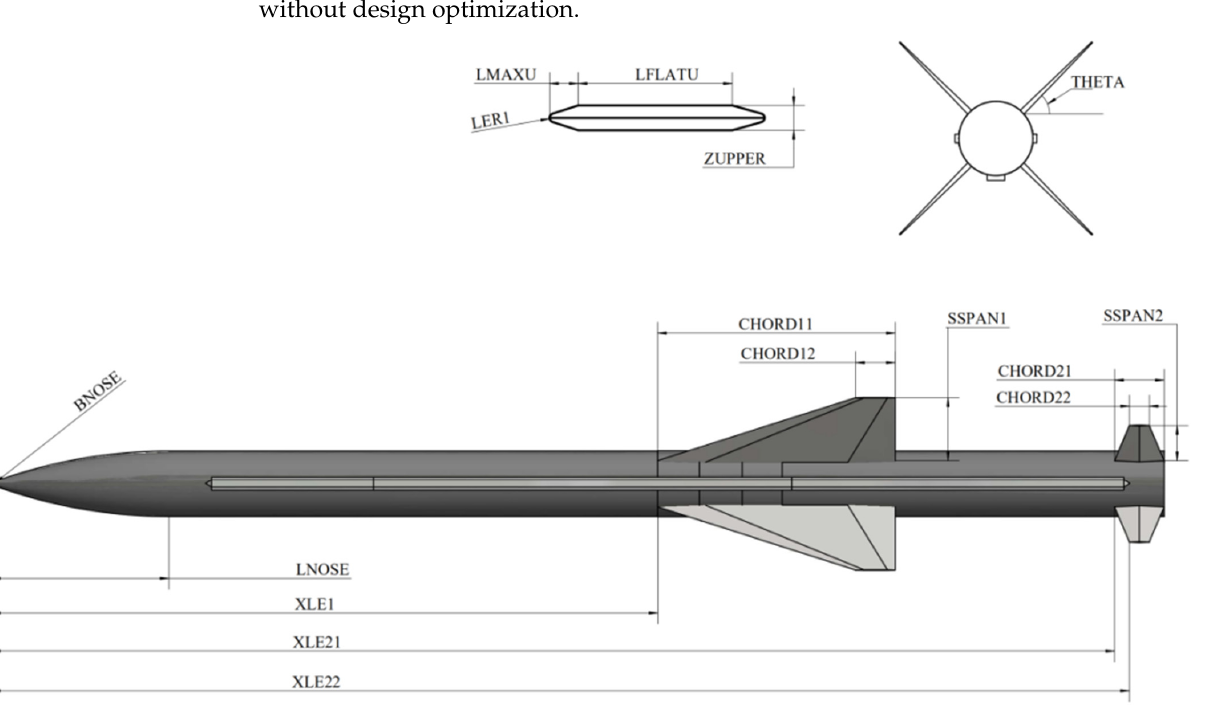
Figure 1. Axisymmetric normal vehicle.